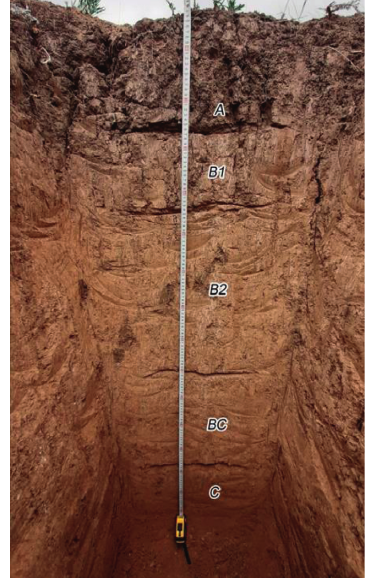
Figure 1: A section of dark chestnut soils.